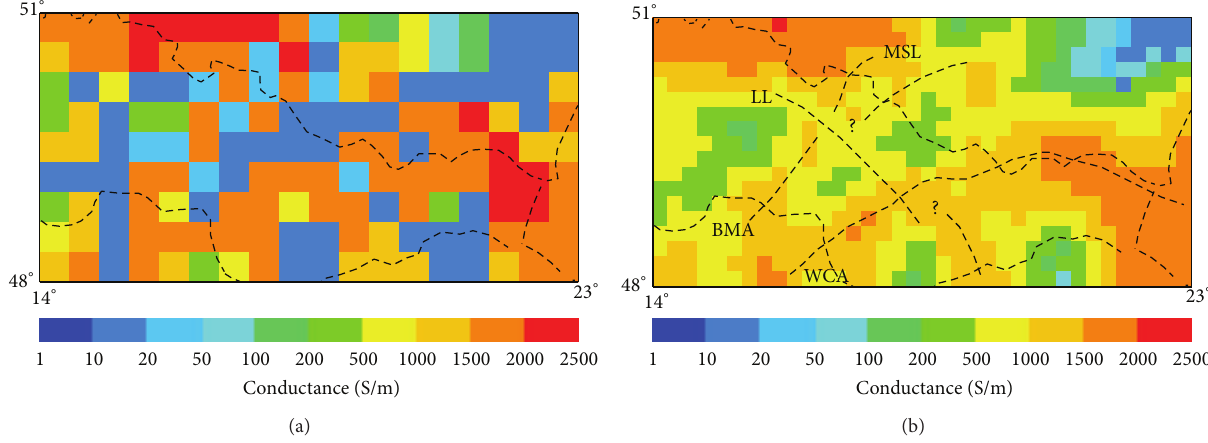
Figure 6: Conductance map from inversion of GDS data with initial block size (a) and after rediscretization of blocks (b). Interpreted anomalies include West Carpathian anomaly (WCA), Bohemian Massif anomaly (BMA), Moravian-Silesian lineament (MSL), and Labe lineament